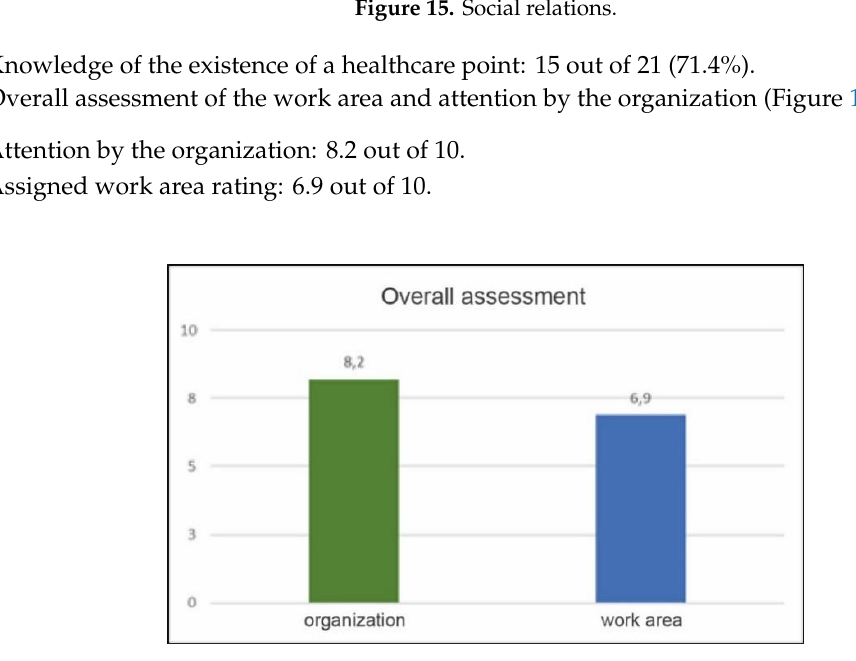
Figure 15. Social relations.